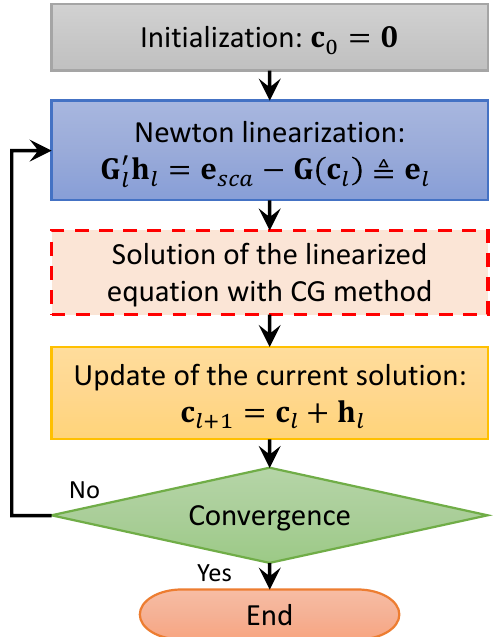
Figure 2. Flow-chart of the external loop of the algorithm employed for the quantitative characterization of dielectric